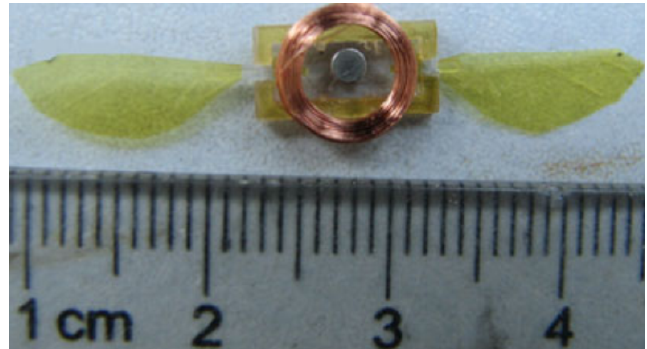
Figure 11. A FWMAV using electromagnetic actuator.